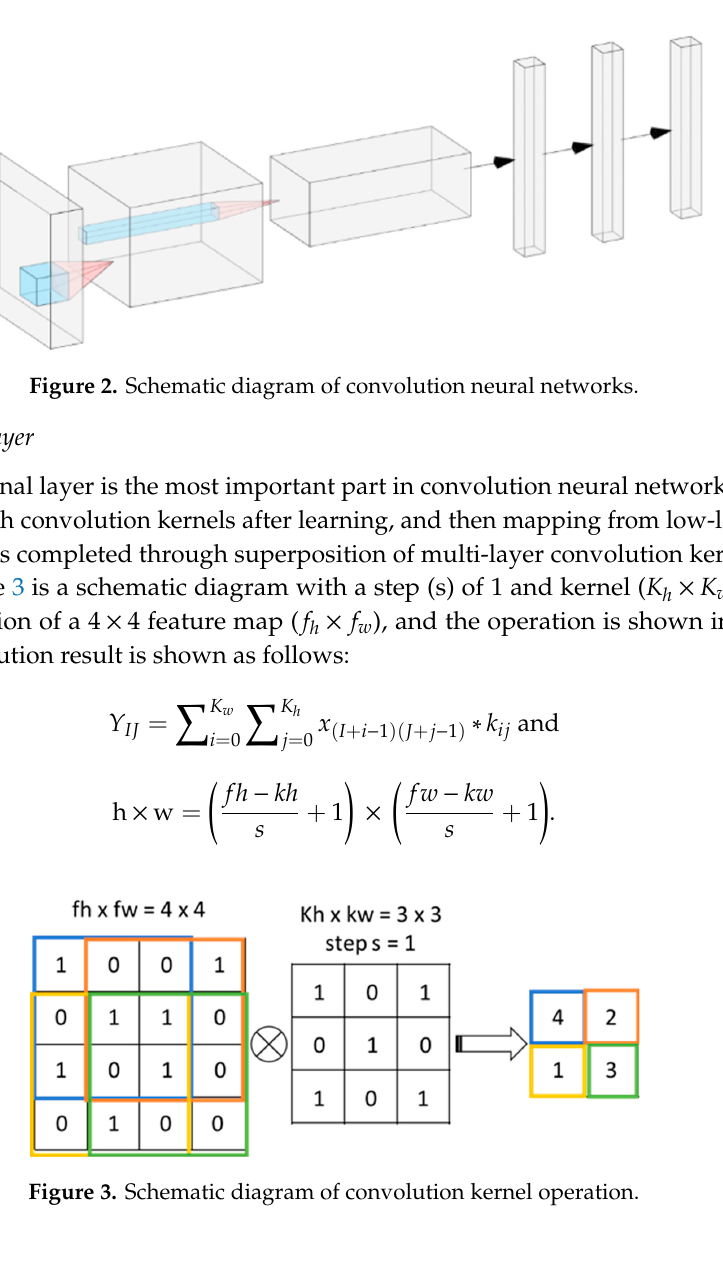
Figure 3. Schematic diagram of convolution kernel operation.